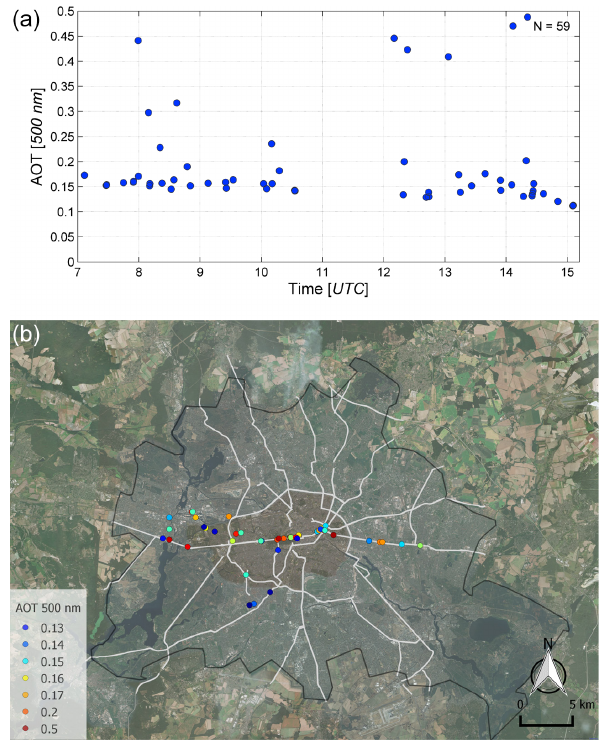
Figure 5. Time series (a) and map (b) of AOTs at 500nm, measured with a Model 540 Microtops II handheld sun photometer and oper- ated from a car which was driving through the city of Berlin during the aircraft overpasses on 21 April 2016.